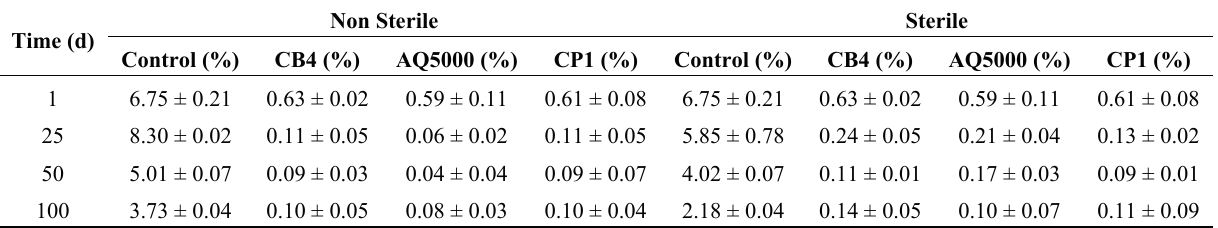
Table 4. 14 C-Phenanthrene uptake (%) by E. fetida in control and 1% AC-amended soils for both non-sterile and sterile soils. Values are mean ± standard error ( n = 3).